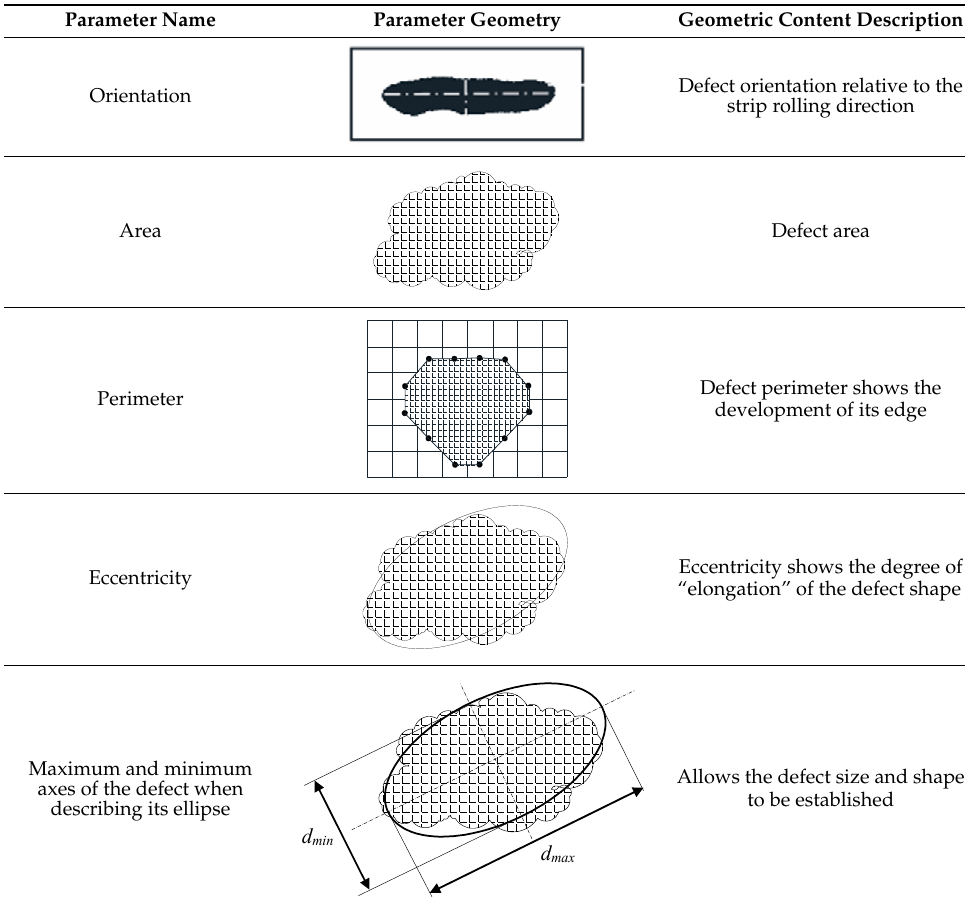
Table 2. Parameters for describing the orientation and geometry of defects.